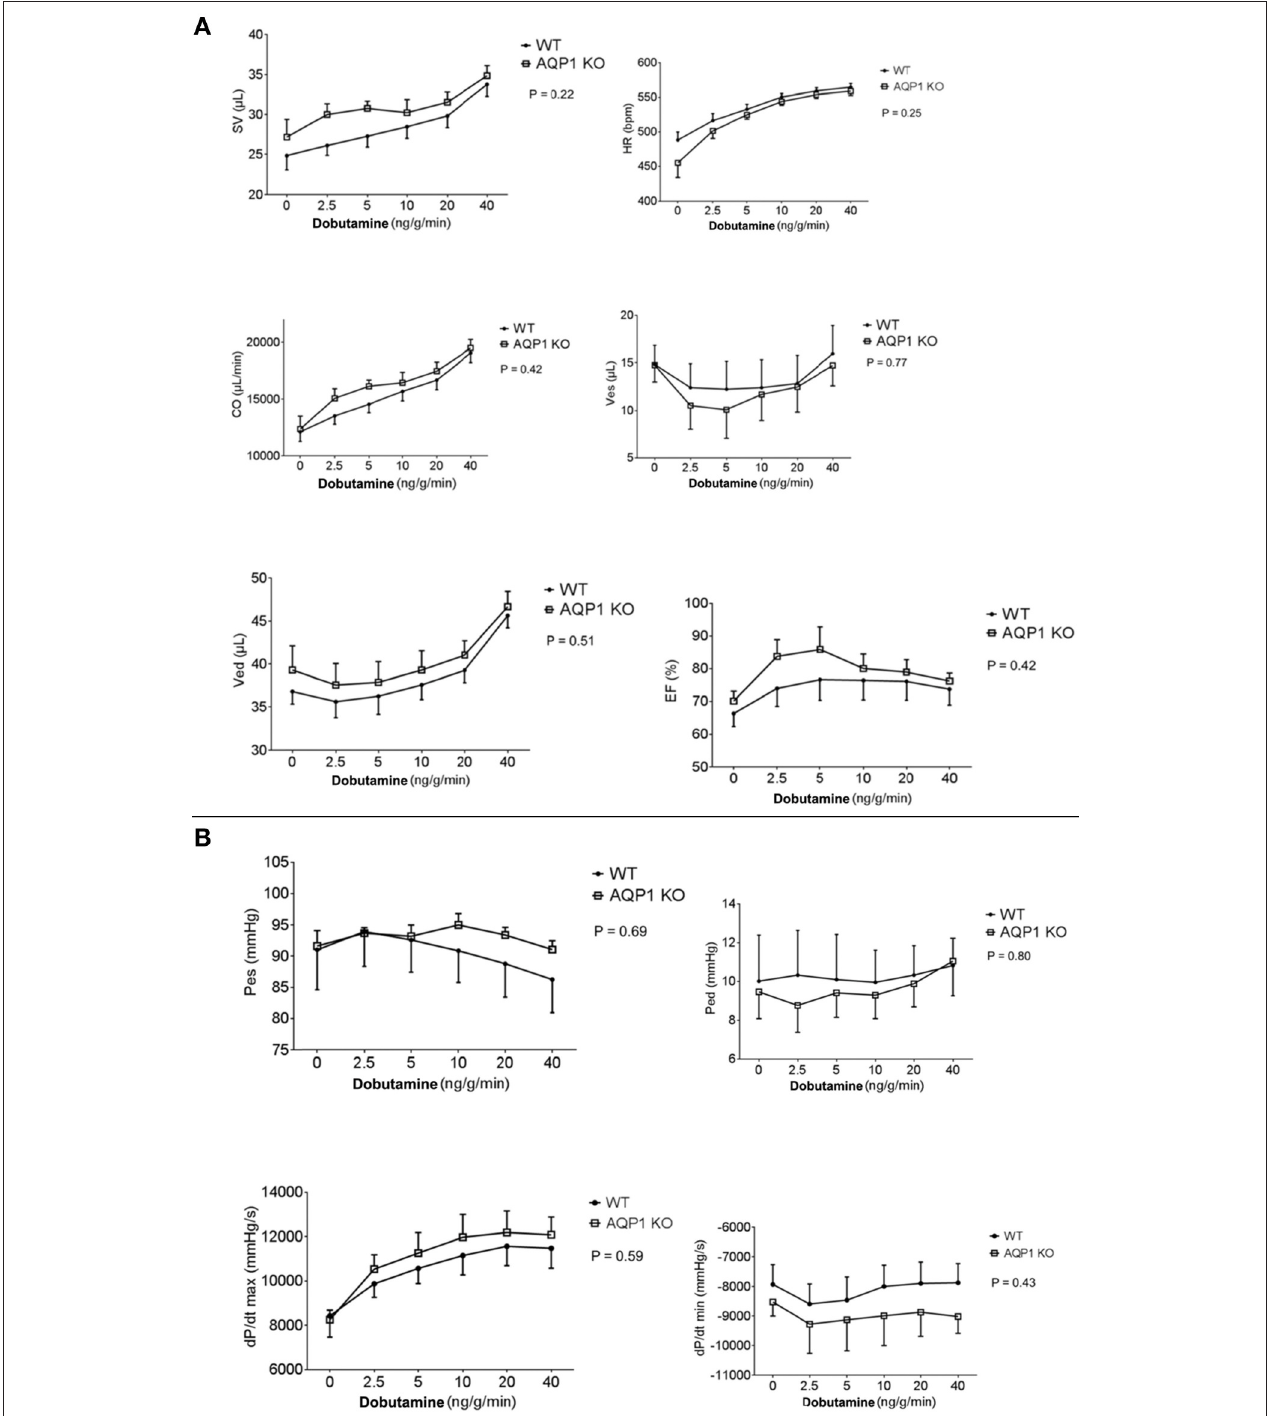
FIGURE 4 | (A) Results from PV loop measurements, averaged from seven hearts from both female and male sexes. SV, stroke volume; HR, heart rate; CO, cardia output; Ves, endsystolic volume; Ved, enddiastolic volume; EF, ejection fraction. Infusion of dobutamine was increased stepwise form 0 to 40 ng/g/min. Two-way repeated measures ANOVA indicates no significant difference between curves, indicating that all parameters of WT and KO behave identically. (B) Results from PV loop measurements, averaged from seven hearts from both female and male sexes. Pes, end-systolic pressure; Ped, end-diastolic pressure; dP/dt, maximal rate of increase of LV pressure; dP/dt, maximal rate of relaxation of LV pressure. All pairs of curves are not significantly different when tested as described in panel (A) .